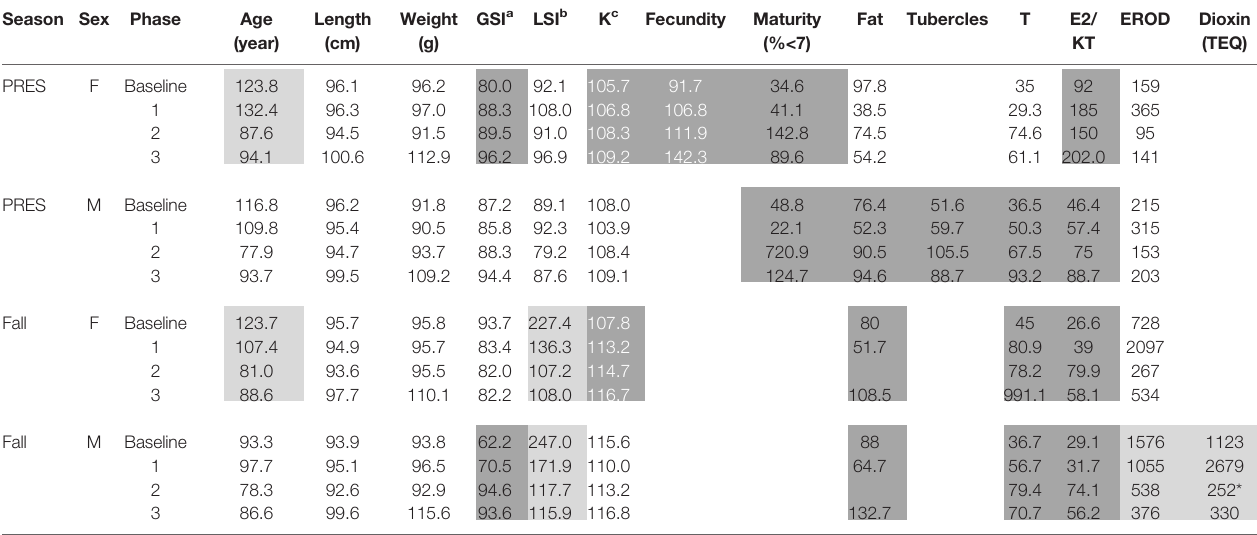
Gray shaded cells represent values decreasing toward reference (light grey) or increasing toward reference (dark grey) and shaded boxes with white text represent increasing away from reference. *Phase 2 Mountain Bay PCDD/F missing; reference average of 1991[1.93] and